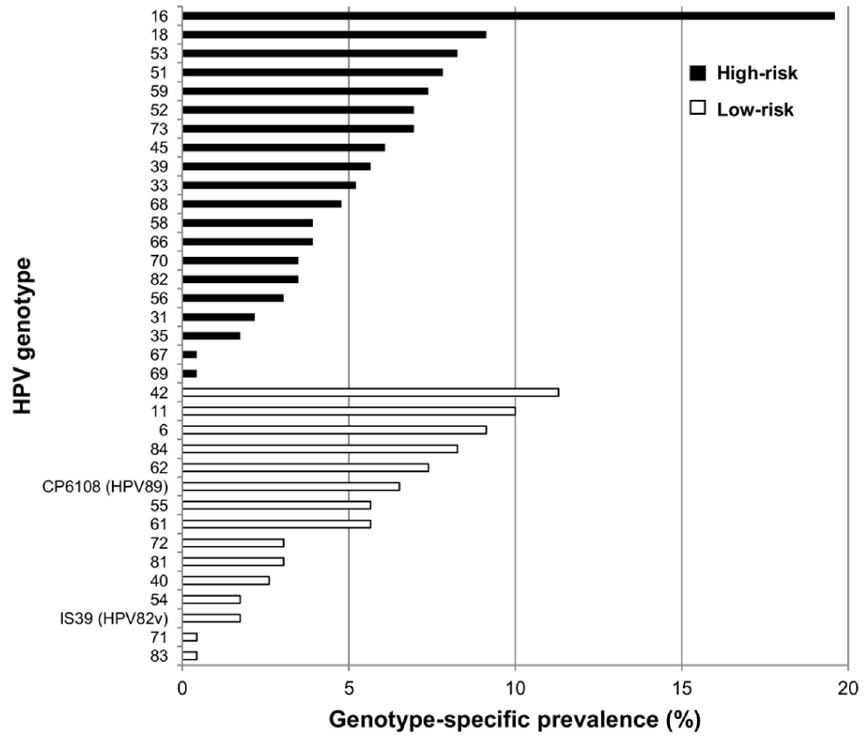
Figure 2. Schematic representation of the main molecular findings regarding the study samples. A. Summary of the Linear Array (LA) results and number of HPV genotypes detected in the LA-positive samples. Side arrows indicate samples excluded from the RCA analysis because of insufficient material. B. Summary of the RCA and virus-specific PCR results for the LA-negative anal samples.